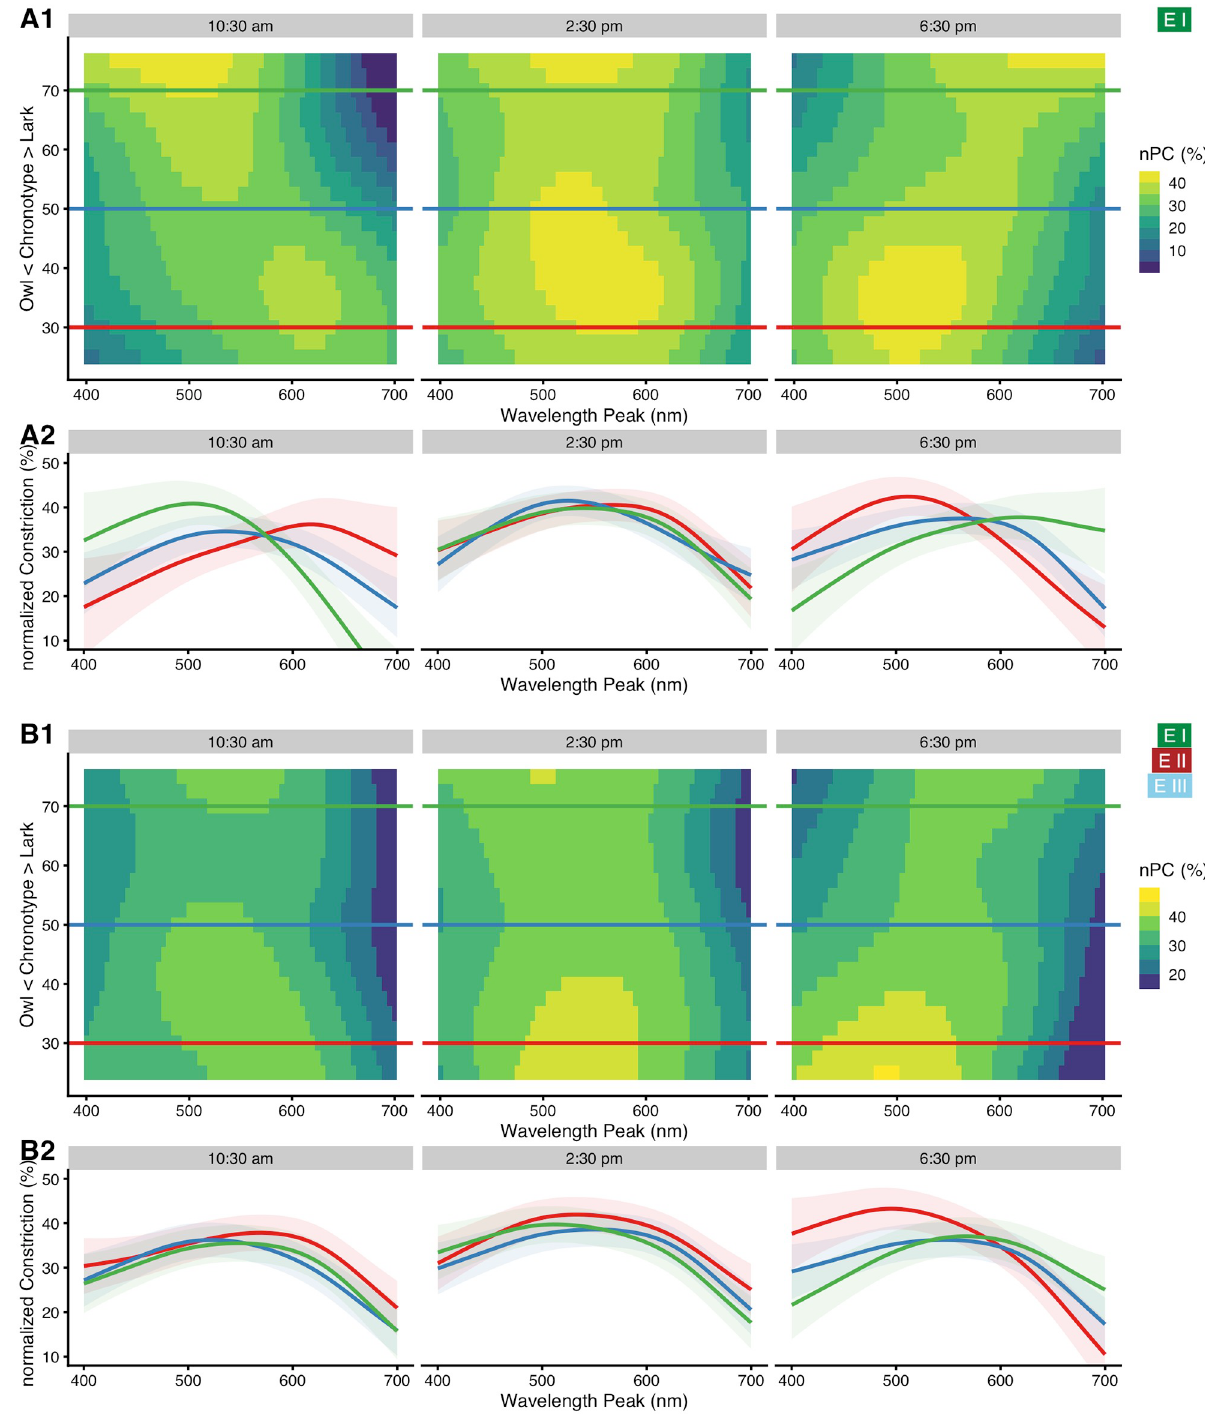
Fig 6. Interaction of wavelength , chronotype , and time of day . (A1) False-color graph of model predictions for the nPC’s dependence on wavelength (x-axis) and chronotype (y-axis) for three times of day, when all other predictors (basic model) are held constant at their average. Horizontal lines show where the respective three traces shown in figure part (A2) are taken from. (A2) Model predictions for the nPC vs. wavelength for three chronotypes (trace color), and three times of day. Green traces show Larks (CT score = 70), red traces Owls (CT score = 30), and blue traces Neutral types (CT score = 50). Ribbons show the 95% confidence interval for the predicted means. (B1/B2) Like (A), but for pooled data across all experiments. See the main text for further details.